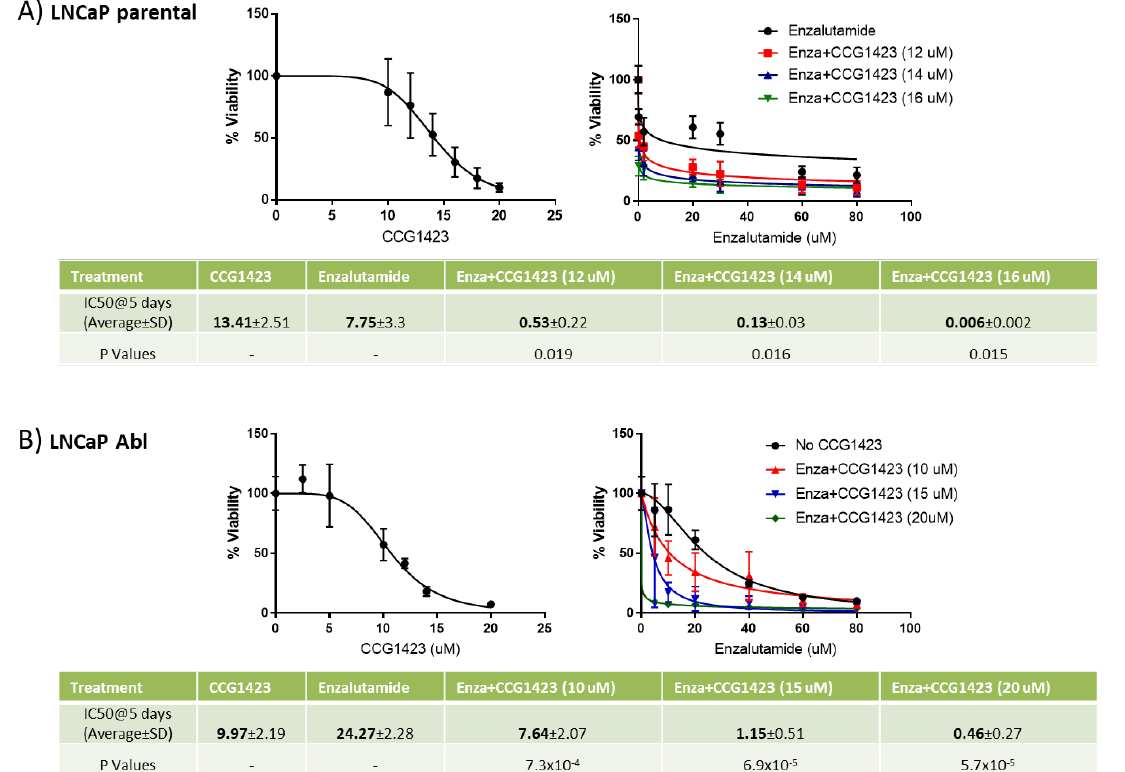
Figure 1. LNCaP cells were seeded in 96 well plates at a density of 3 × 10 3 cells per well. The following day, they were treated either with vehicle (DMSO), increasing concentrations of CCG1423 alone (parental: 10, 12, 14, 16, 18, 20 μM; Abl: 2.5, 5, 10, 12, 15, 20 μM), increasing concentrations of enzalutamide alone (parental: 0.2, 2, 20, 30, 60, 80 μM; Abl: 5, 10, 20, 40, 60, 80 μM) or all the 36 possible combinations of CCG1423 and enzalutamide. Five days after treatment, cellular viability was measured by 3-(4,5)-dimethylthiazol-2-yl-2,5-diphenyltetrazolium bromide (MTT) assay. IC50 values were calculated using Prism. ( A ) LNCaP parental; ( B ) LNCaP Abl. The graphs show % viability at different concentrations of CCG1423 and enzalutamide from three independent experiments in triplicate. Only three concentrations of CCG1423 are shown in the graph for better visualisation of curves. The tables show average IC50 values from three independent experiments in triplicate ± standard deviation (SD). IC50 values were compared using t test assuming equal variance. For each column, p -values refer to comparisons between that column and single treatment with enzalutamide.